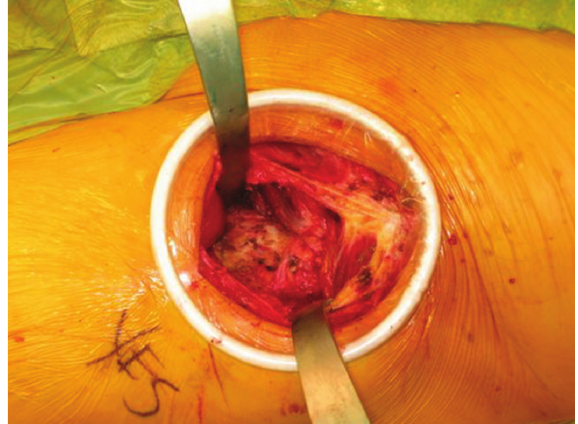
Figure 1: Exposure of the joint capsule seen through the Dexterity Protractor ring (Dexterity Surgical Inc., Roswell, GA, USA) which self-retracts and protects the skin and soft